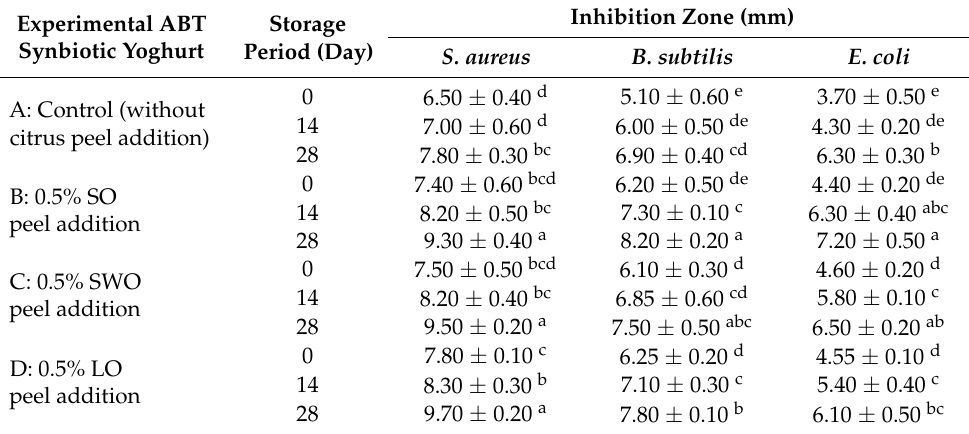
Table 3. Antibacterial efficiency of crude extract from ABT synbiotic yoghurt with citrus peel addition during cold storage (5 ± 1 ◦